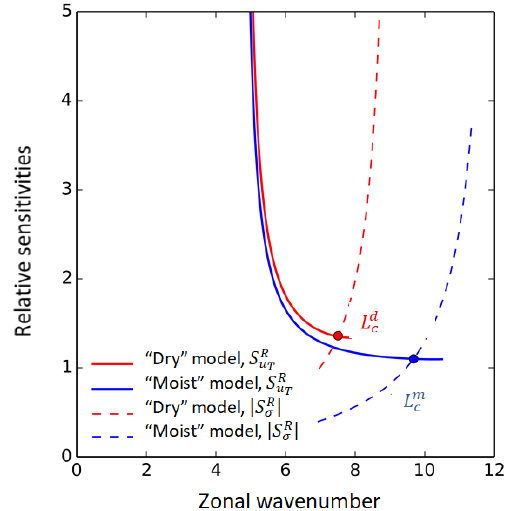
Figure 5. Relative sensitivity functions for “dry” and “moist” models.